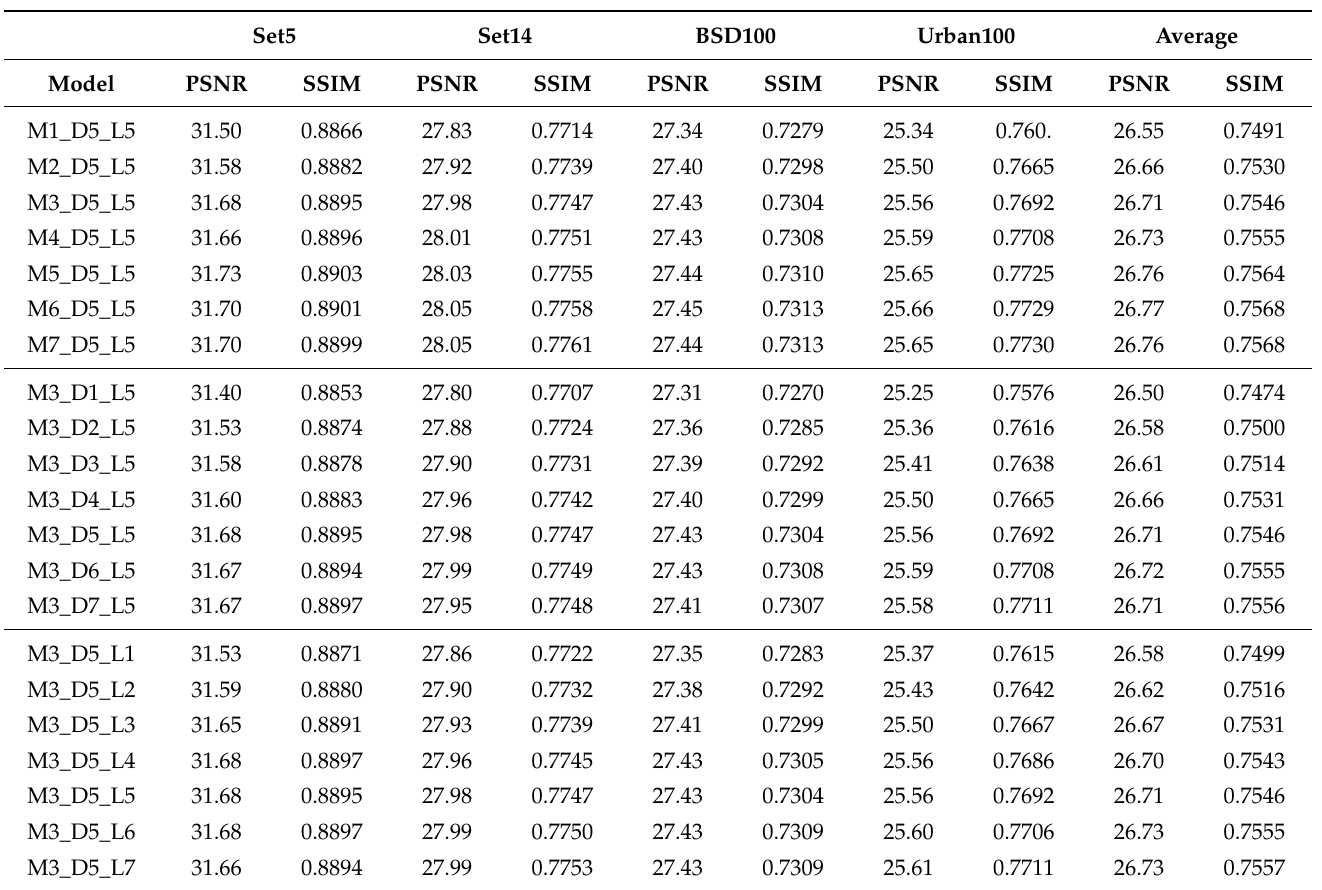
Table 9. SR Performances on test